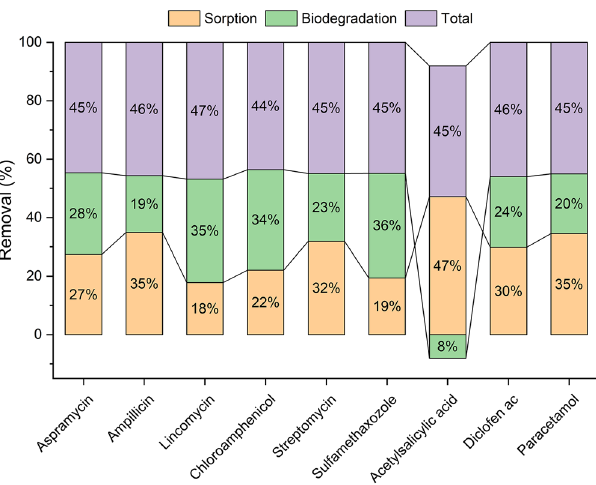
Figure 4. Removal percentages of pharmaceutical compounds in different stages of